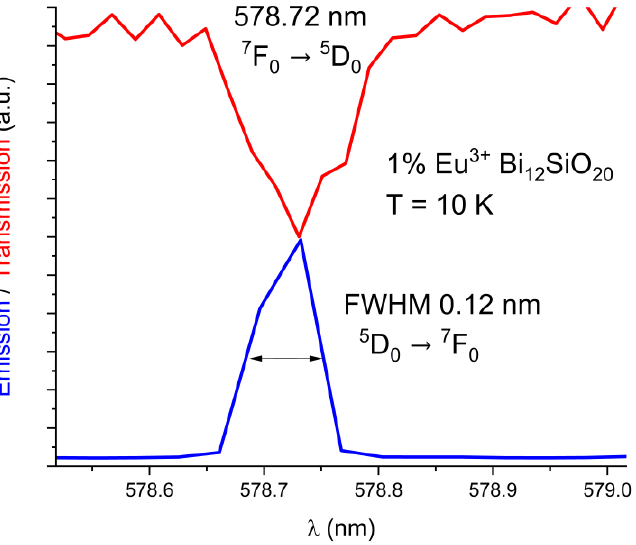
Figure 3. Low-temperature (10 K) absorption line 7 F 0 → 5 D 0 overlaid with the 5 D 0 → 7 F 0 emission line in line in BSO.